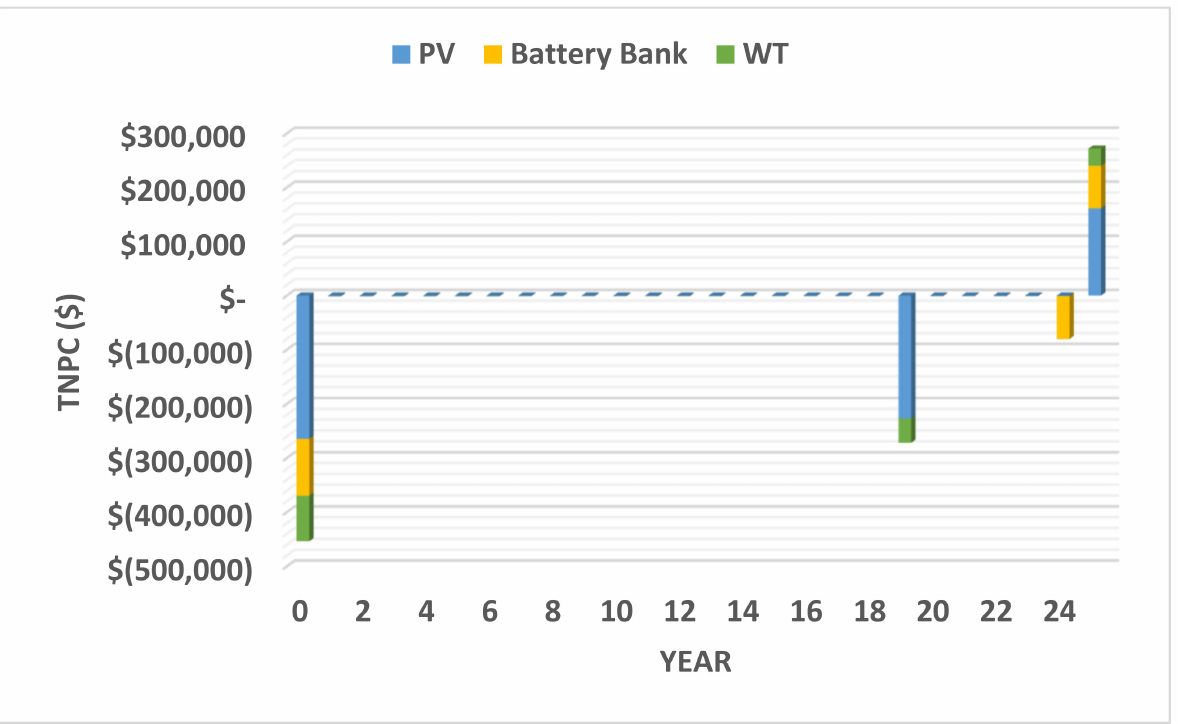
Figure 10. The Discounted Cash Flows of the optimum system.